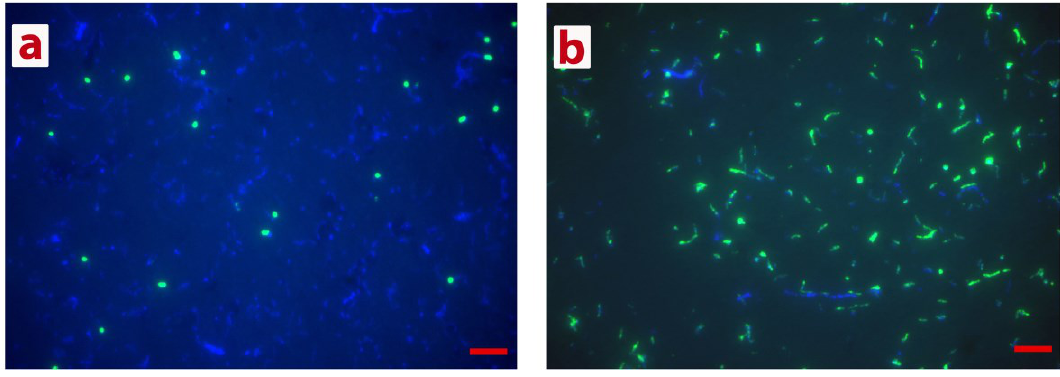
Figure 1. Direct microscopic observations of CARD-FISH- and DAPI-stained cells in Thetis GB-degrading enrichment. Coccoid cells positive for Archaea-specific probe Arch915 ( a ); and polymorphic single cells and chains of rod-shaped cells positive for EUB338 I, II, III probe mix ( b ) were visualized in GB-degrading Lake Thetis enrichment from the depth of 3500 m. Red scale bars denote: 5